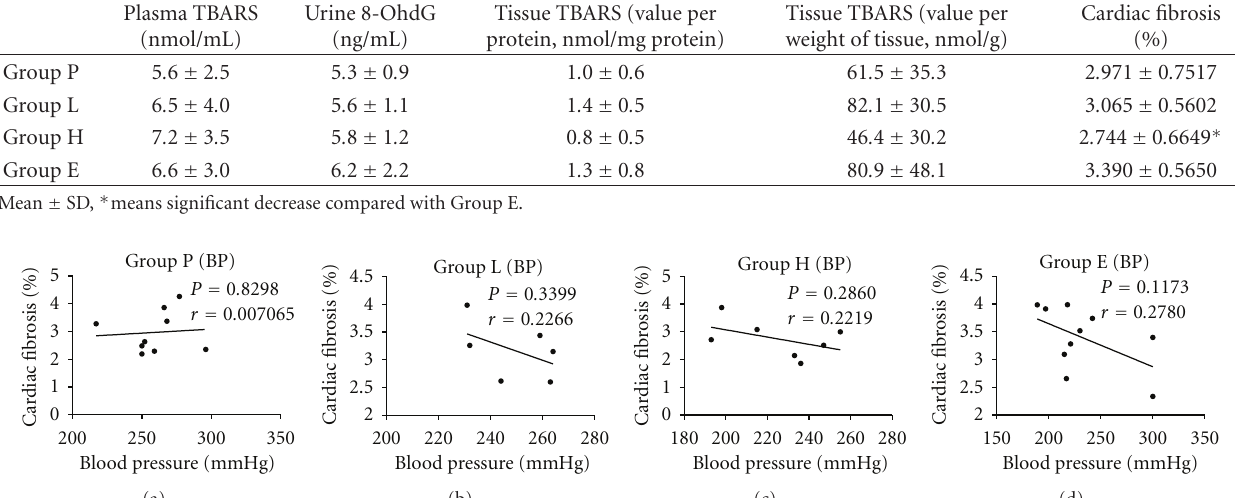
Table 2: Urine 8-OHdG, plasma, tissue TBARS, and fibrosis. The detailed data relating to urine 8-OHdG, plasma, and tissue TBARS and fibrosis. Cardiac fibrosis was lowest in Group H, and there were significant di ff erences between Group E ( P = 0 . 014).